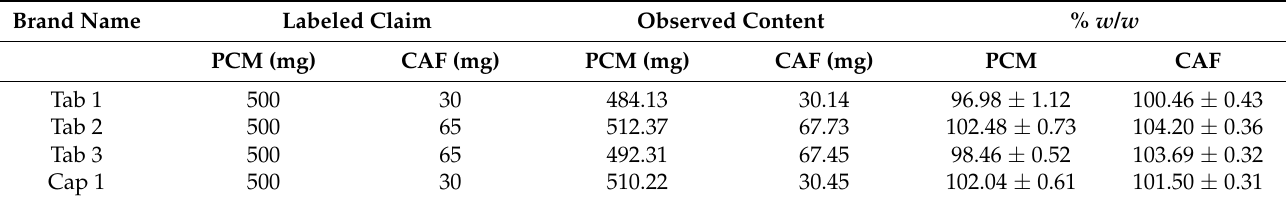
Table 5. PCM and CAF contents in fixed-dose combinations.